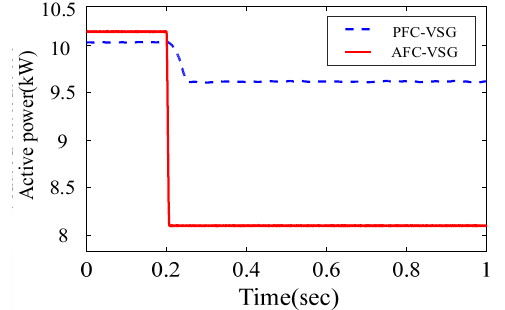
Figure 10. Active power regulation ability between the PFC-VSG and the AFC-VSG under the sudden load decrease condition.